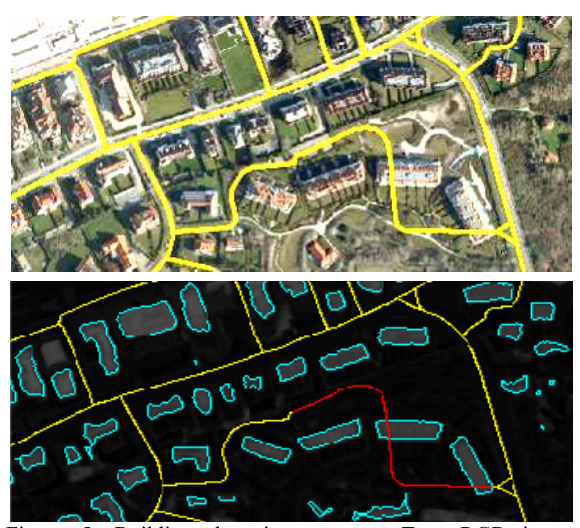
Figure 5: Building detection strategy. Top: RGB image superimposed with database roads containing one incorrect road object. Bottom: nDSM superimposed with extracted buildings (cyan) and evaluation result (rejected road = red, no decision = yellow) Grassland Detection: In (Zhang, 2004) and (Youn et al., 2008)